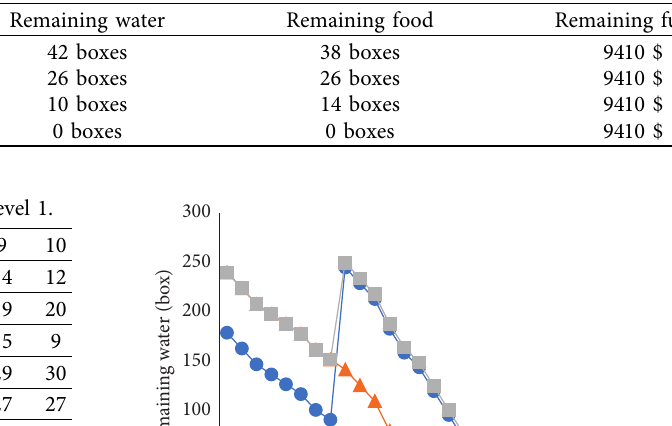
Table 7: The best strategy and the remaining resources of the first situation in Level 1.